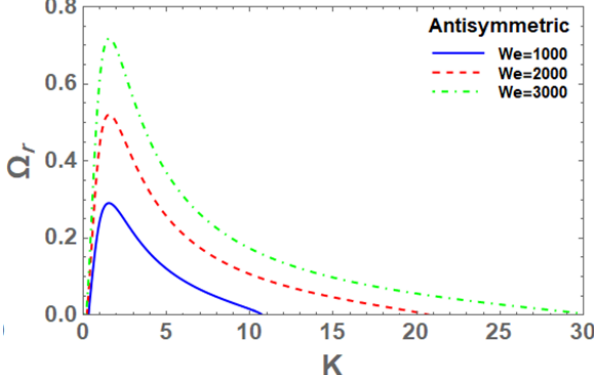
Figure 3. For various Weber numbers We , the variation in the non-dimensional growth rate Ω r depends on the non-dimensional wave number K , We , when N = 1; Oh = 0.1; ρ = 0.01; linebreak n = 1; v = 0.2; κ 1 = 2; ˜ (cid:101) l = 0.3; ˜ (cid:101) g = 0.1; E = 3; U = 1.5; V (cid:48) = 0.1; ε = 0.5, for axisymmetric disturbance case.